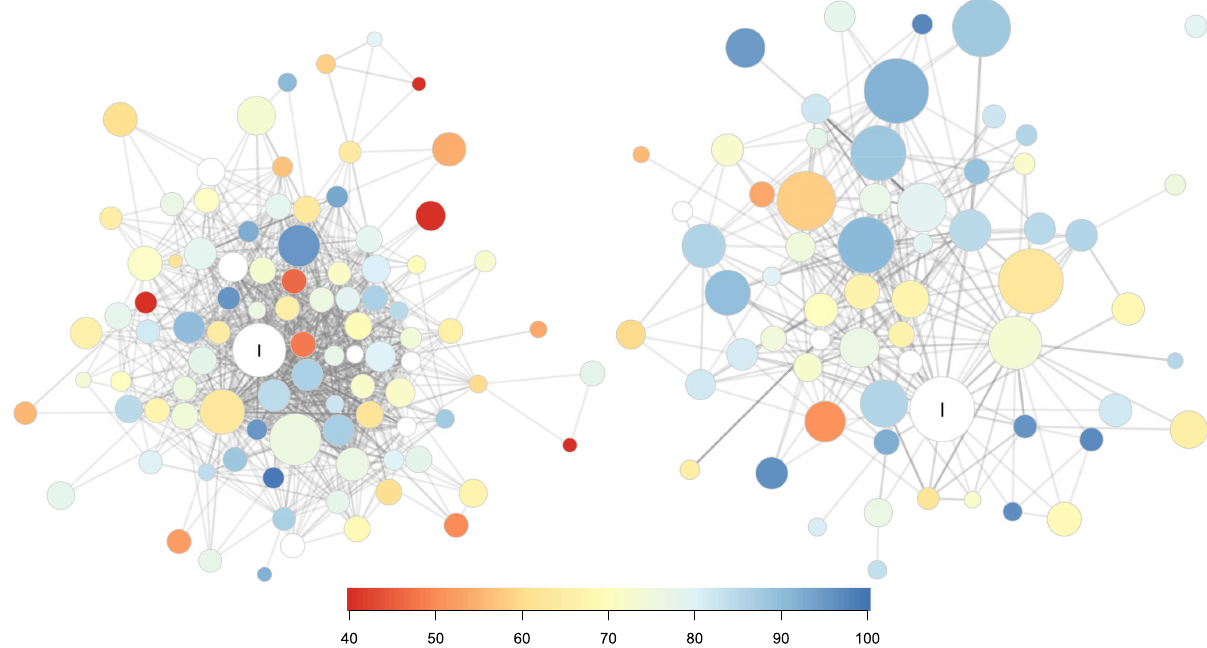
0.33***FIG. 4. Forum networks from weeks 7 – 8 in semester 1 (left) and semester 2 (right). Line opacity is scaled by edge weight, so darker lines indicate more threads in common for a student pair. Nodes are sized by total contributions over the semester and colored by grade (red low, yellow medium, blue high). Nodes without grades (withdrawals and instructor or CN staff accounts) are white, and the instructor ’ s node is labeled “ I.